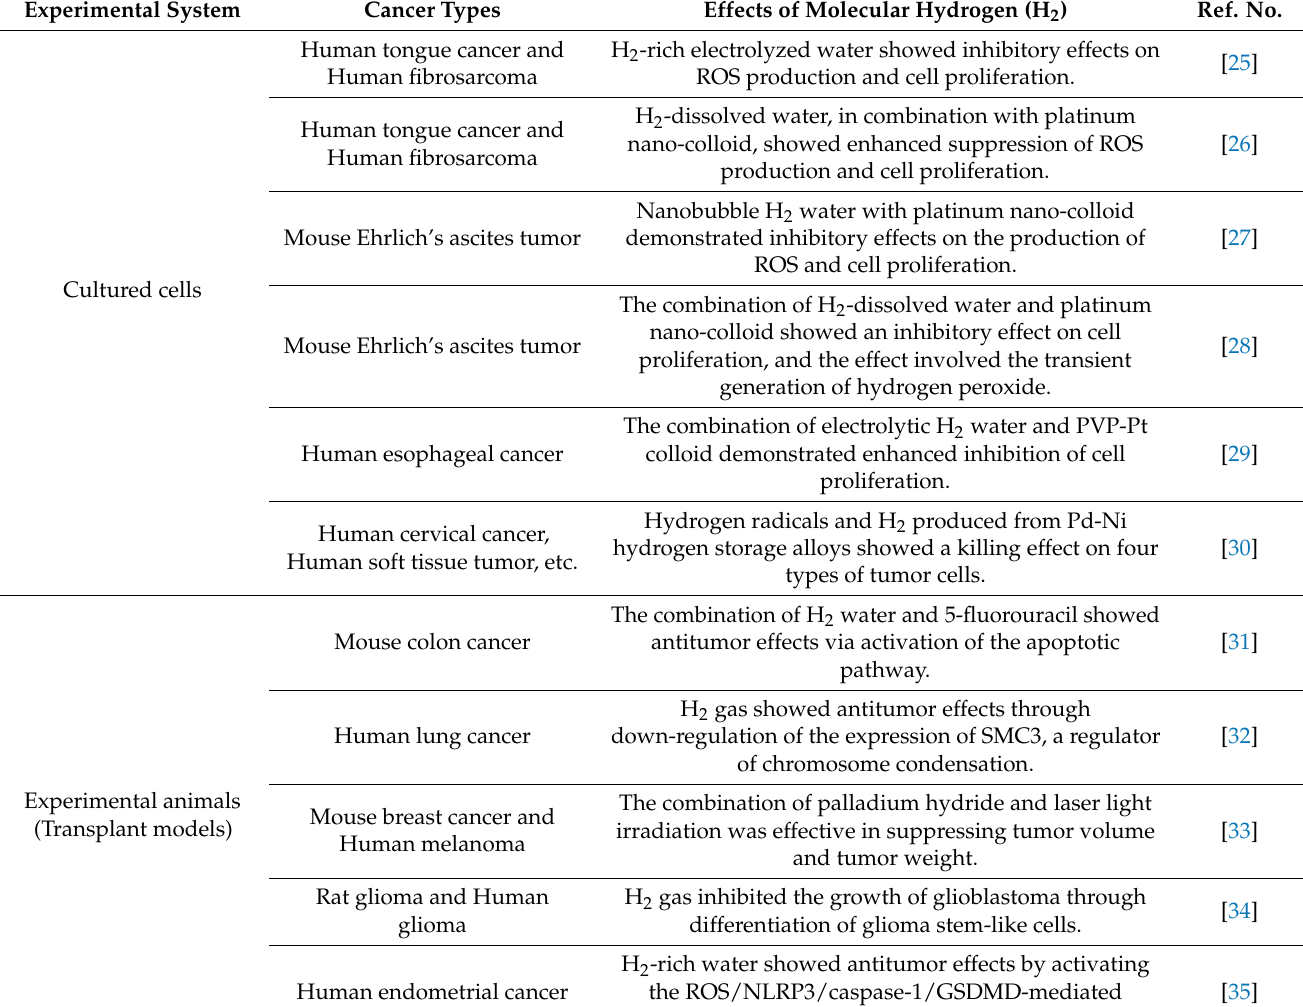
Table 1. Summary of antitumor effects of molecular hydrogen (H 2 ) in cellular models and animal models. Experimental System Ref.